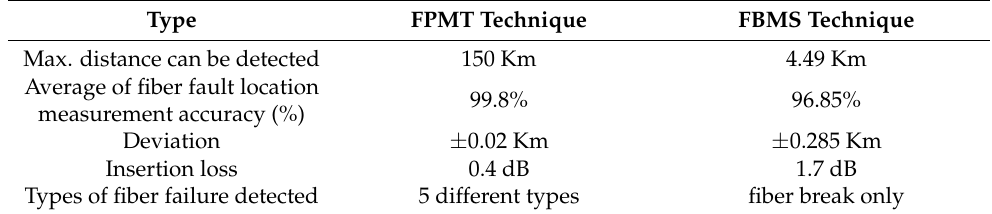
Table 8. Comparison between the proposed FPMT technique and the FBMS online